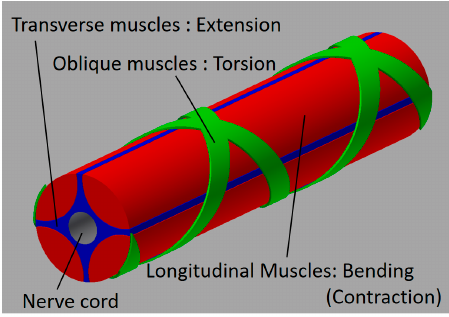
Figure 4. The structure of the octopus arm.